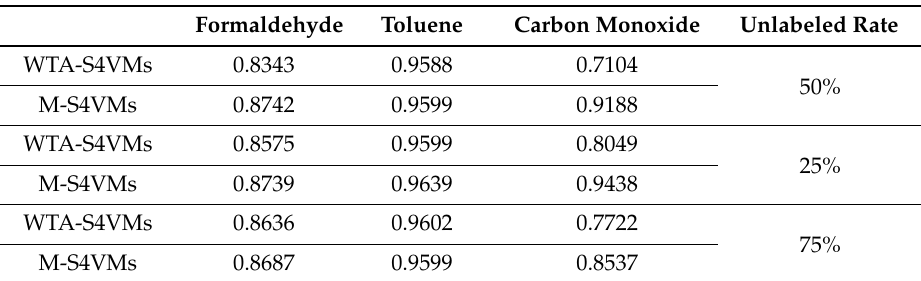
Table 8. Outcome of the target gases accuracy rate at different unlabeled